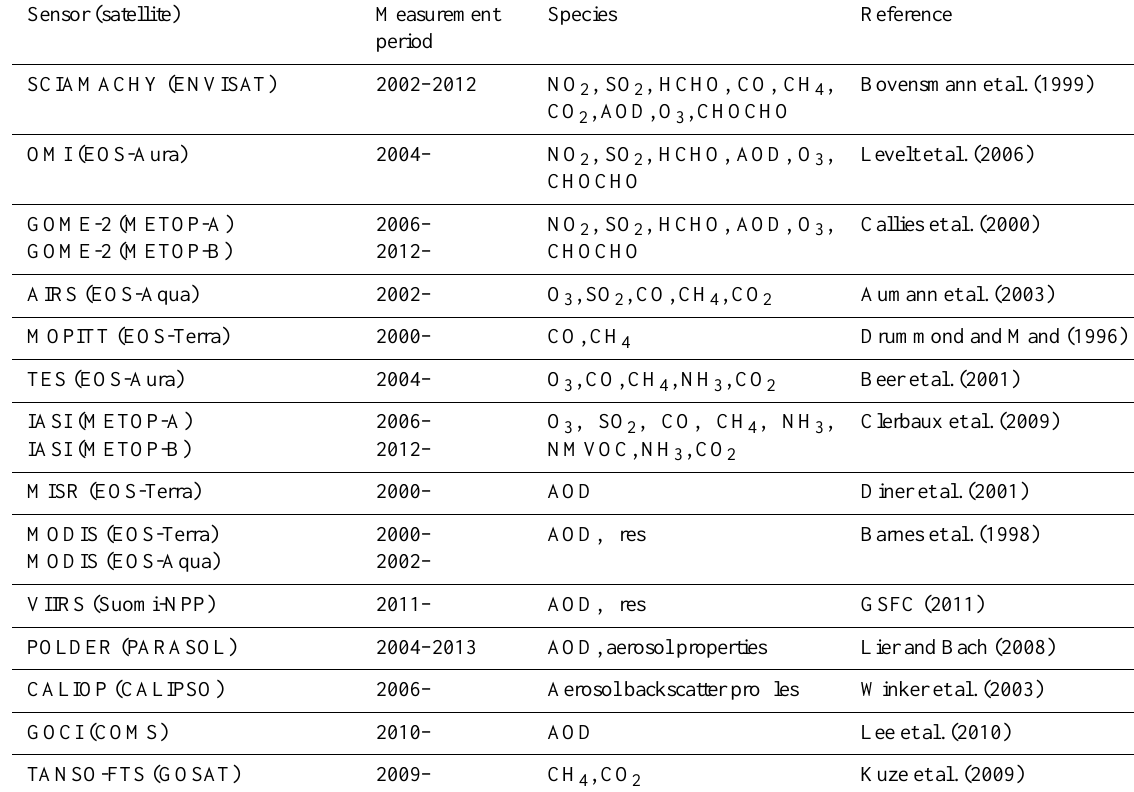
Table 1. Summary of major satellite instruments for the period 2003 to the near future, and the atmospheric composition species detected by these instruments. The focus is on tropospheric